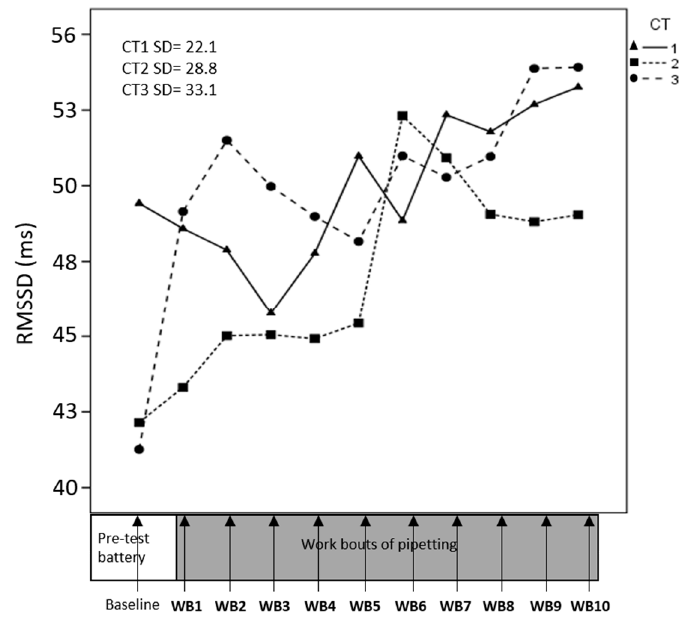
Figure 4. Heart rate (HR) across consecutive pipetting work bouts (WB). At each time point on the x- axis, corresponding to the pipetting work bouts, a mean value for HR across participants is presented. Separate lines illustrate the three cognitive task (CT) difficulties. Standard deviations (SD) refer to all participants and all time points.